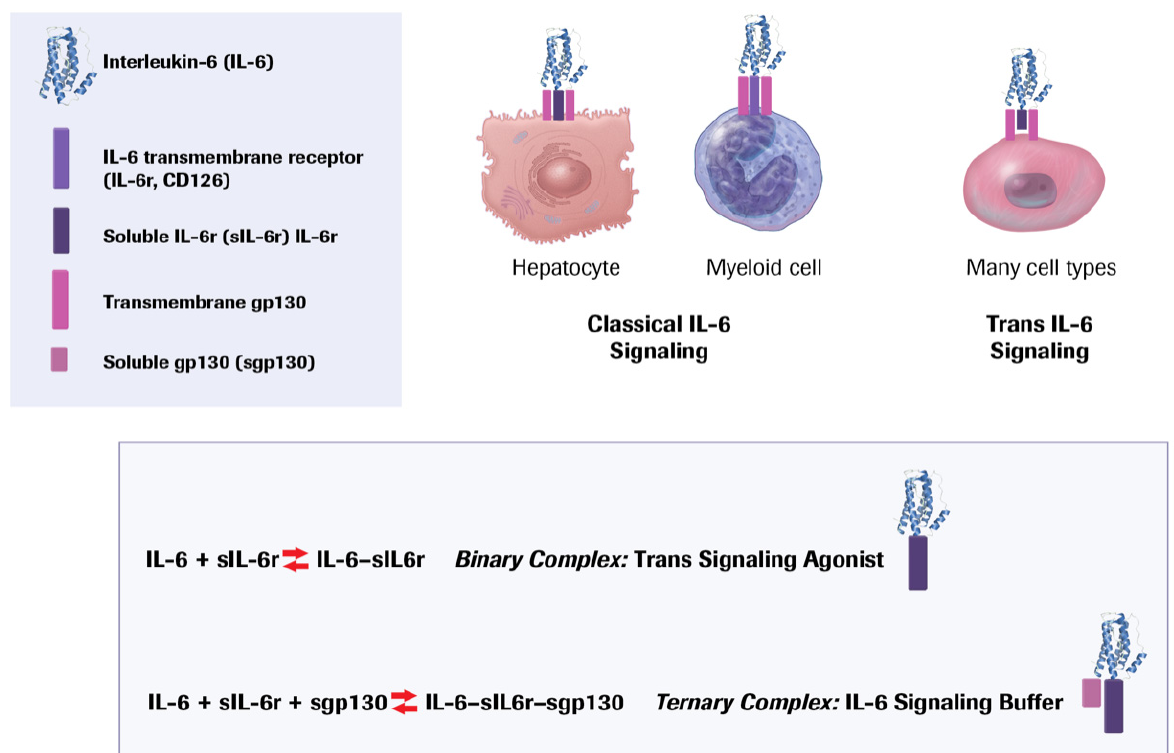
Figure 8. IL-6 signaling is complex and subject to multiple levels of regulation. As described in the text, classical IL-6 signaling involves binding of the ligand to the membrane bound IL-6 receptor (CD 126.) Hepatocytes and leukocytes express this receptor, which associates with gp130 to initiate transmembrane signaling. However, the surface IL-6 receptor can also undergo limited proteolytic cleavage by ADAM 17, releasing a soluble form of this receptor. This soluble IL-6 receptor can bind to the IL-6 and form a binary complex. This binary complex can bind to gp130, which is expressed ubiquitously, effecting trans IL 6 signaling to multiple cell types. A soluble form of gp130 can combine with the binary complex, forming a ternary complex that sequesters IL-6 bound to its receptor, providing a buffer for trans IL-6 signaling. A common variant in the IL-6 receptor can promote its shedding, depleting the hepatocyte or leukocyte surface of this receptor (CD126), limiting classical signaling, but increasing formation of the binary complex by mass action, and thus favoring trans IL-6 signaling.